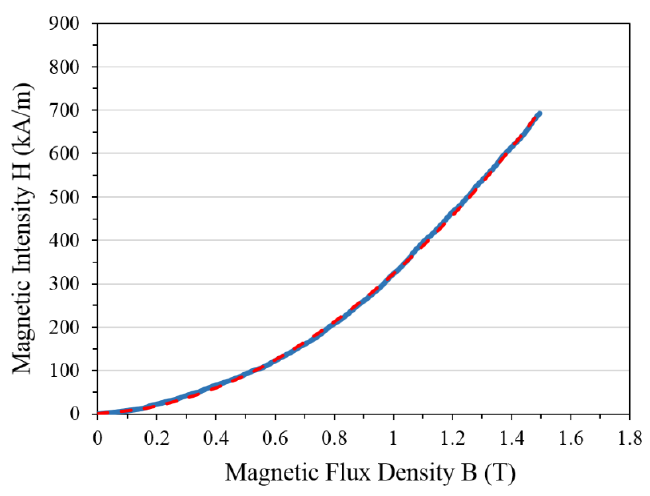
Figure 5. The B–H curve of the MRF-132DG from Lord Corporation [16].